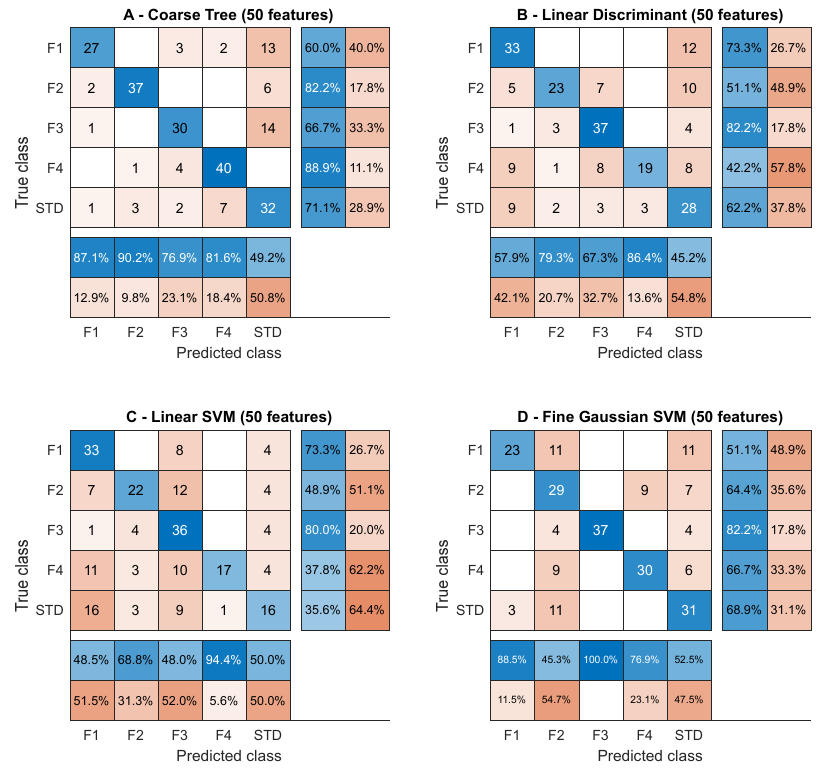
Figure 11. Classifier accuracy ( A ) and training time ( B ) with 50 features (raw signal, sensor 1).